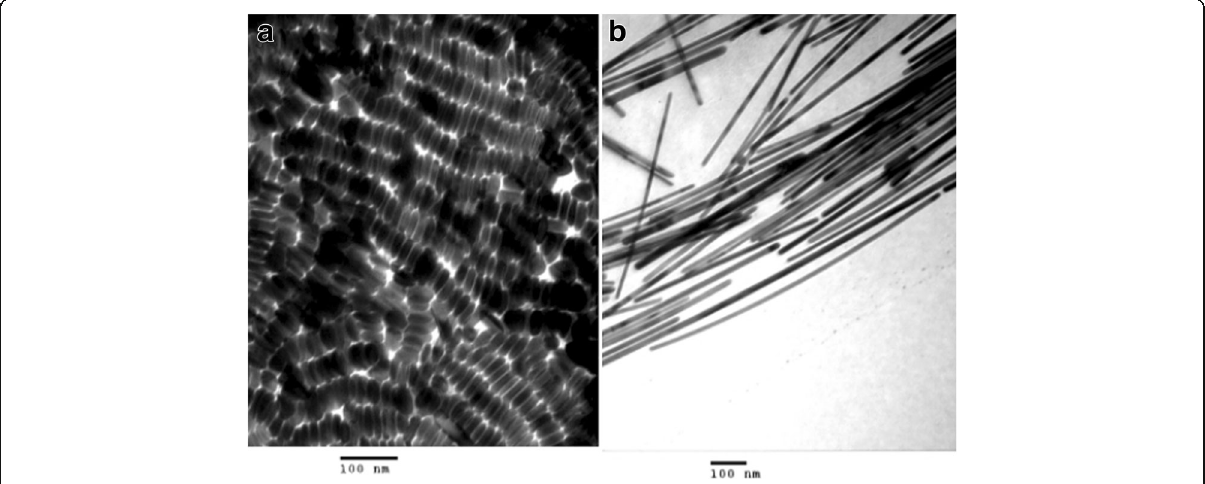
Fig. 2 a Shape-separated silver nanorods from a preparation with 0.06 mL seed. b Shape-separated silver nanowires